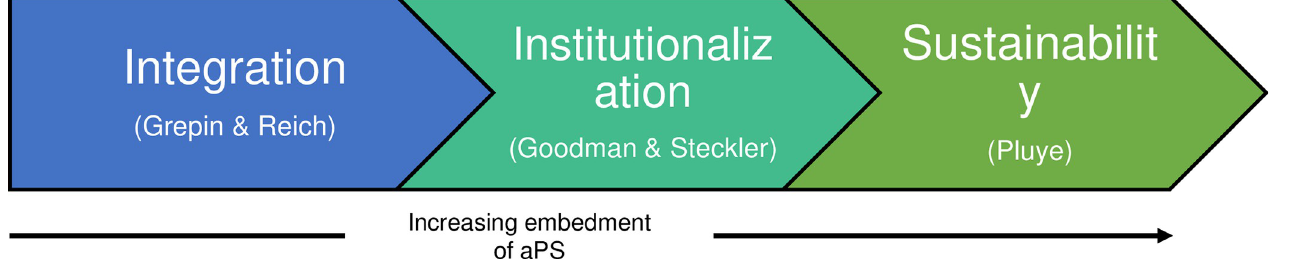
Fig 1. Conceptual framework of aPS integration in Kenya’s HTS program.